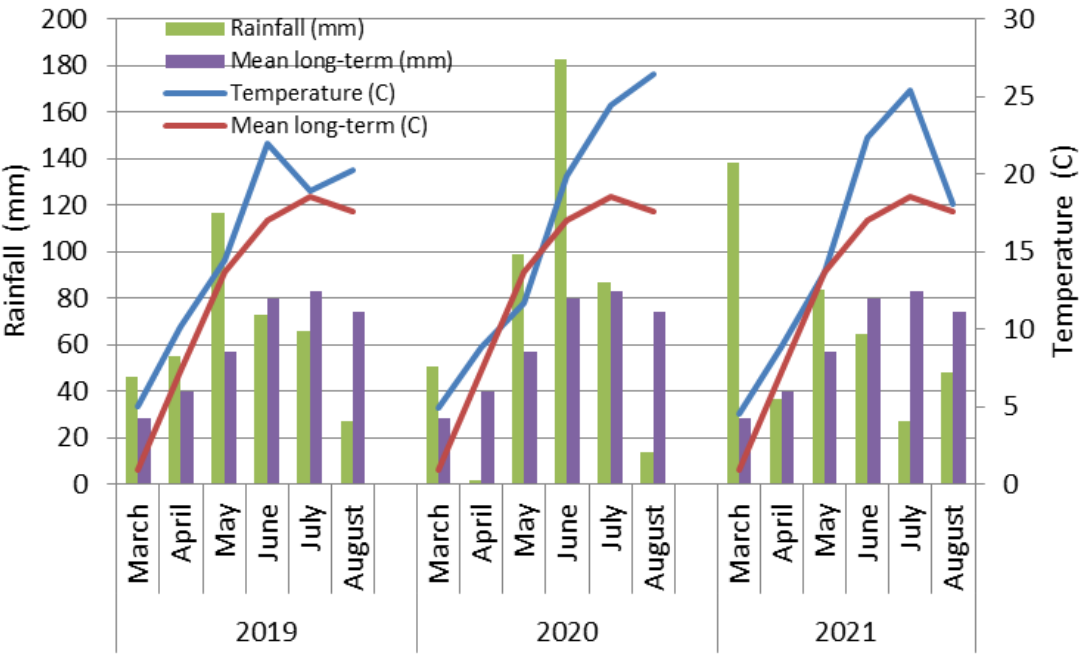
Figure 2. Mean monthly temperatures and rainfall at the experimental site during the experimental period as well as the long-term 1991–2021 trend.